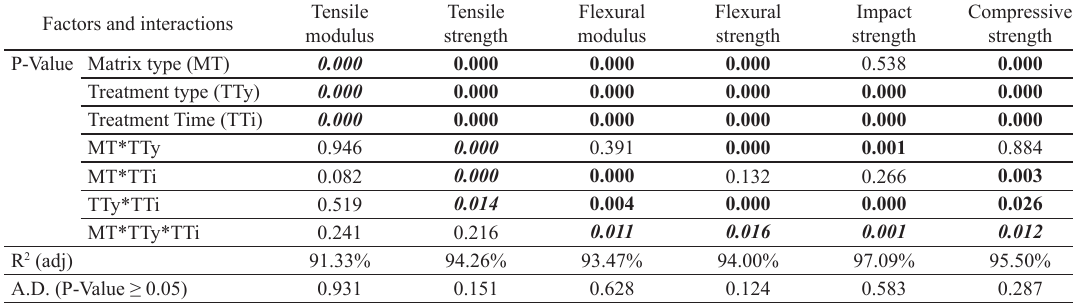
Table 4. ANOVA (DoE) results for mechanical